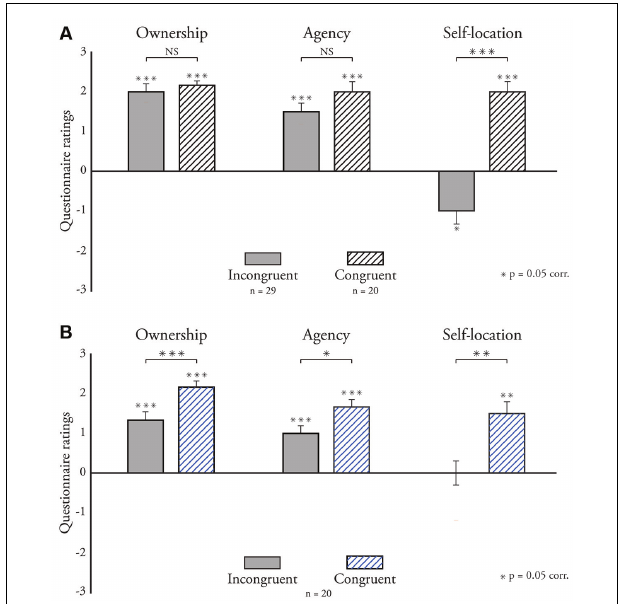
FIGURE 2 | Median questionnaire ratings. (A) Experiment 1. We compared questionnaire ratings between the incongruent ( n = 29) and congruent ( n = 20) groups on body ownership, agency, and self-location. (B) Experiment 2. We measured and compared participants’ ratings of body ownership, agency, and self-location in the congruent and incongruent conditions ( n = 20). Error bars indicate the standard error. ∗ p < 0.05; ∗∗ p < 0.005; ∗∗∗ p < 0.0005; NS, Not